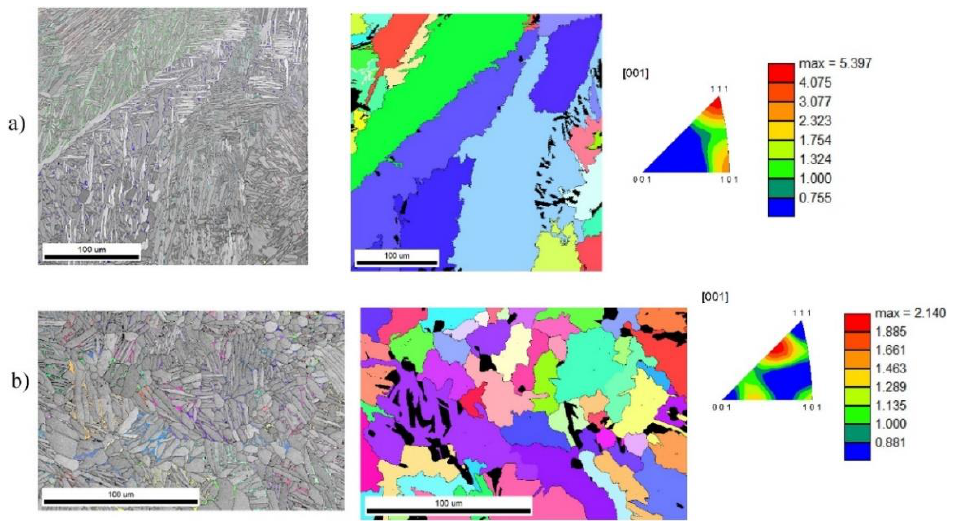
Figure 26. Microstructure and EBSD maps of samples manufactured by ( a ) continuous laser mode and ( b ) pulses laser mode [129]; published under open-access license of